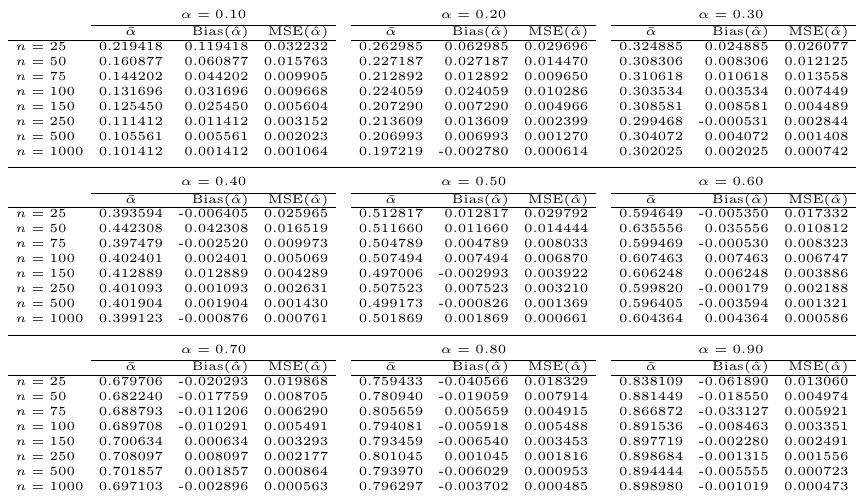
Table 2. ML estimates.